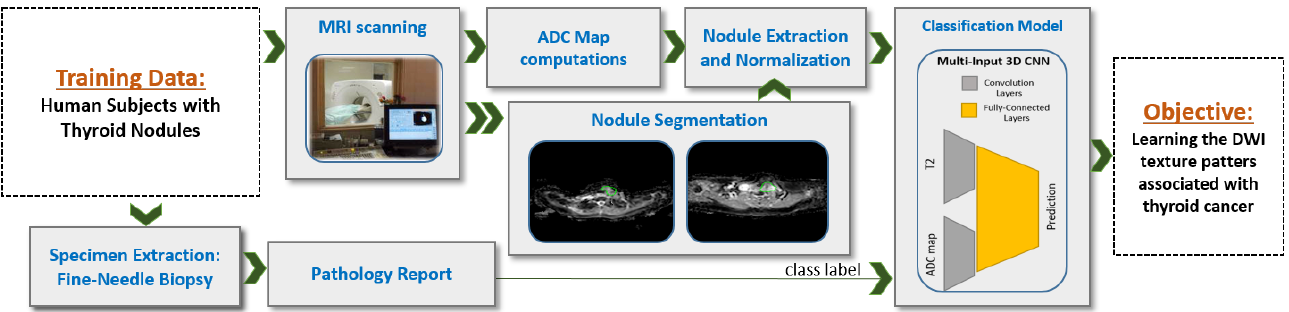
Figure 2. Schematic diagram that represents the training pipeline for the proposed system. MRI data were collected from human subject cohort. ADC maps were computed in order to prepare the two inputs for the CNN. The objective of the proposed system was to learn the texture patterns in DWI images and correlate them with pathological